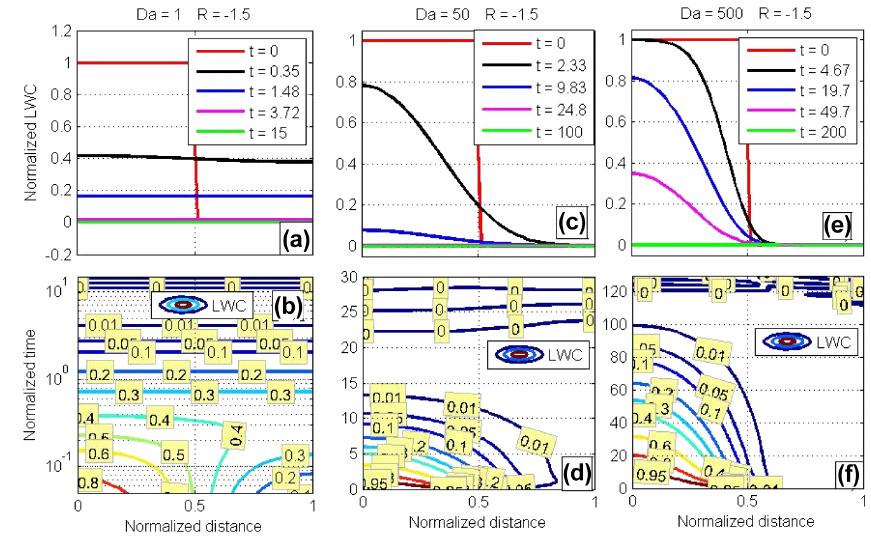
Figure 4. The same as in Fig. 3, but for normalized LWC. Left bottom panel is plotted in semi-log